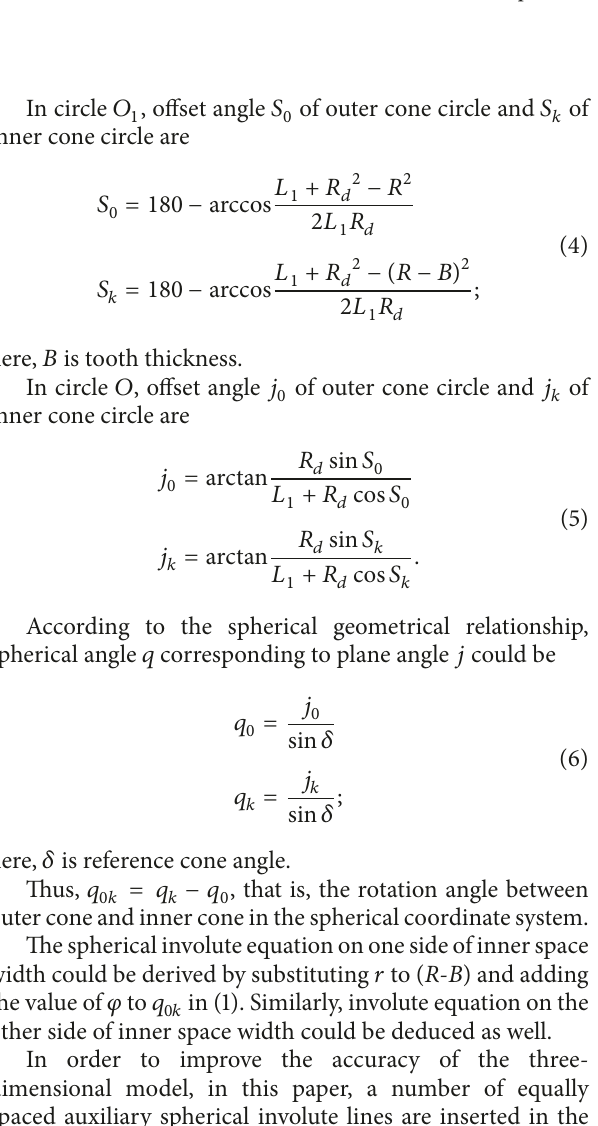
Figure 2: Spiral bevel gear assembly model.